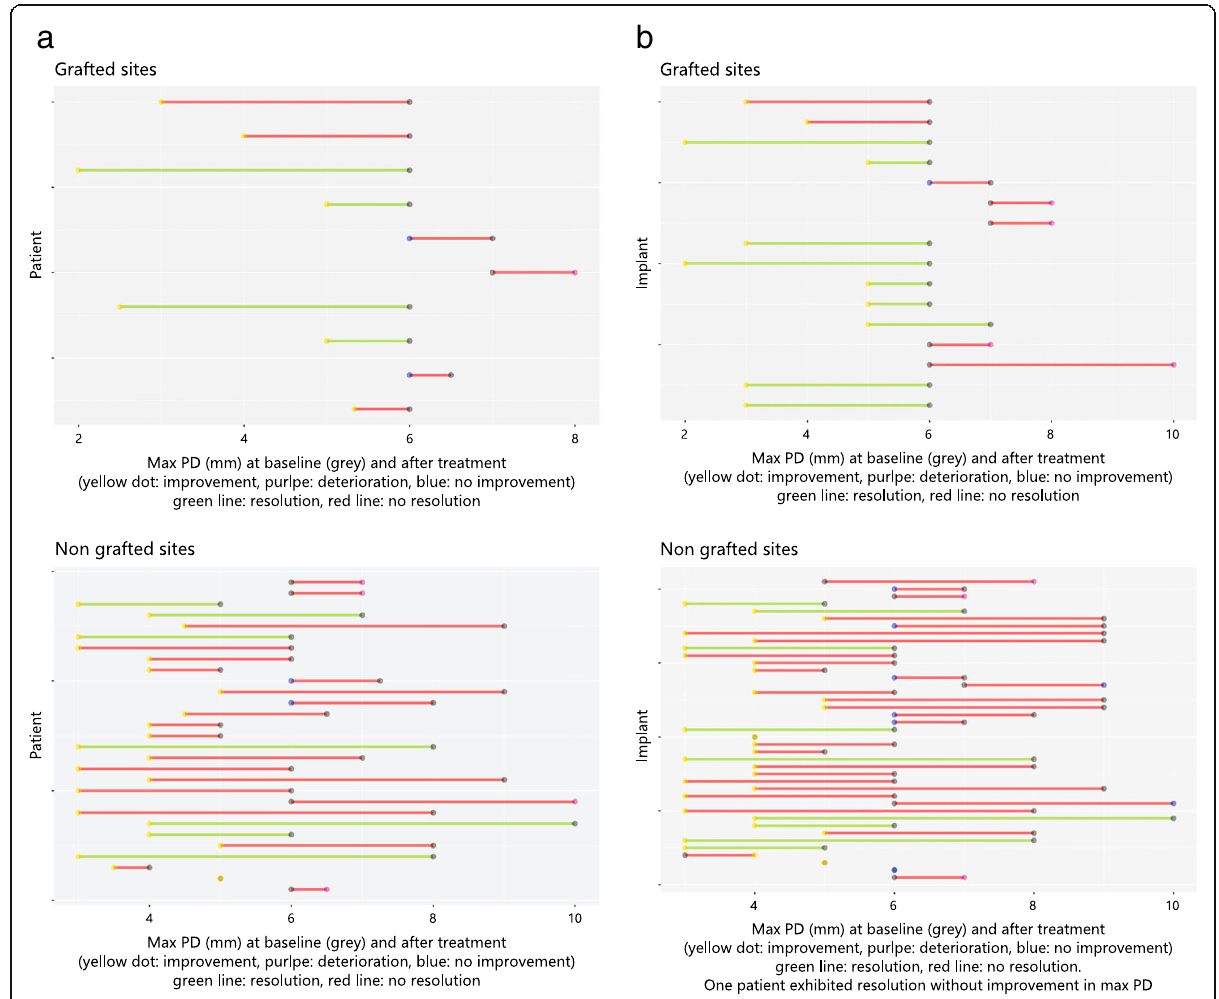
Fig. 3 Dumbbell — dot plots illustrating ( a ) disease resolution and no resolution at non-grafted and grafted sites at the patient level analysis with no significant difference between the two groups ( p = 0.579). Patents with improvement, deterioration, and no improvement following the treatment based on the max PD changes are depicted; ( b ) disease resolution and no resolution at the implants in non-grafted and grafted sites. Significantly higher disease resolution in the grafted implant group ( p = 0.048)